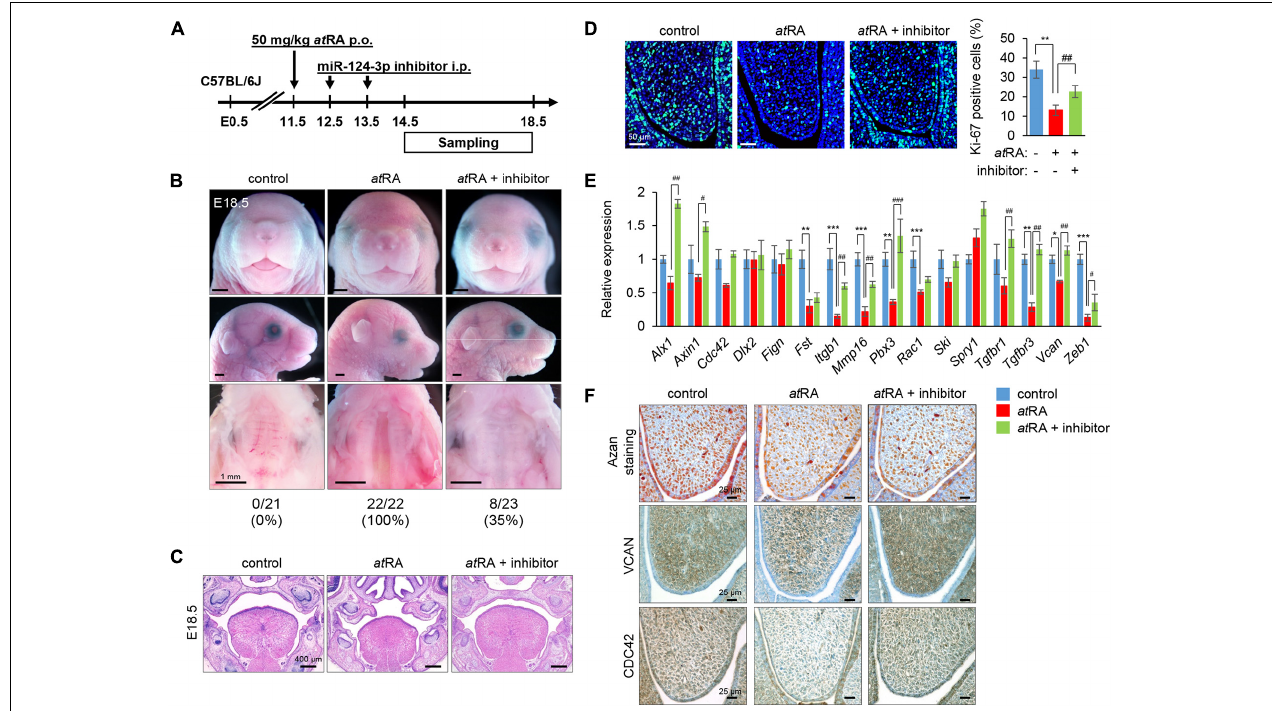
FIGURE 6 | Inhibition of miR-124-3p expression rescues at RA-induced CP in mice. (A) Schematic experimental design. (B) Gross picture of E18.5 C57BL/6J mice treated with control vehicle, at RA, or at RA + miR-124-3p inhibitor. Bars, 1 mm. (C) H&E staining of the face of E18.5 C57BL/6J mice treated with control vehicle, at RA, or at RA + miR-124-3p inhibitor. Bars, 400 µ m. (D) Ki-67 staining (green) in the developing palate of E13.5 C57BL/6J mice treated with/without a miR-124-3p inhibitor under at RA condition. Nuclei were counterstained with DAPI (blue). Representative images from two independent experiments are shown. Graph shows the quantification of Ki-67 positive cells. One-way ANOVA with Tukey’s honest significant difference test. ** p < 0.01 vs. control. ## p < 0.01 vs. at RA. Bars, 50 µ m. (E) Quantitative RT-PCR for the indicated genes after treatment with/without a miR-124-3p inhibitor under at RA condition in the palatal shelves of E14.5 C57BL/6J mice. Two-way ANOVA with Tukey’s honest significant difference test ( n = 3). *Adjusted p < 0.00313 (16 genes), **adjusted p < 0.000625 (16 genes), and ***adjusted p < 0.0000625 (16 genes) vs. control. # Adjusted p < 0.00313 (16 genes), ## adjusted p < 0.000625 (16 genes), and ### adjusted p < 0.0000625 (16 genes) vs. at RA. (F) AZAN staining (upper panels) and immunohistochemical staining for VCAN (middle panels; brown) and CDC42 (bottom panels; brown) in E13.5 C57BL/6J mice treated with control vehicle, at RA, or at RA + miR-124-3p inhibitor. Bars, 25 µ